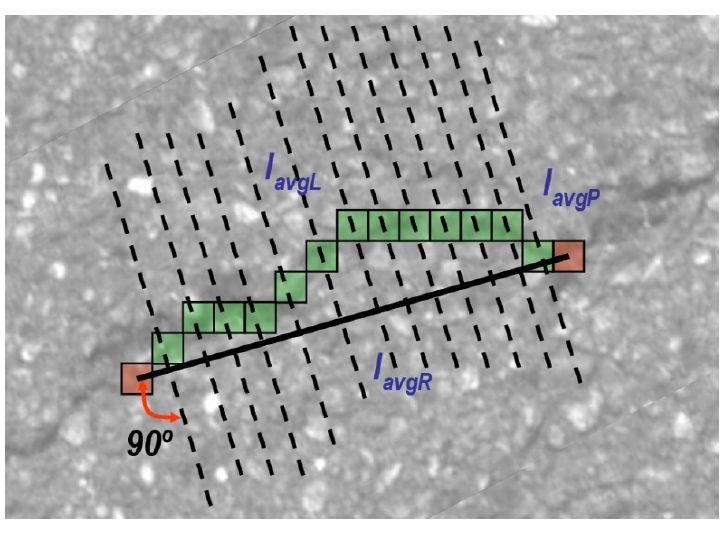
Figure 16. Path quality check. Linear windows are orthogonal to the orientation between the seeds (seeds are depicted in red and pixels of the path are depicted in